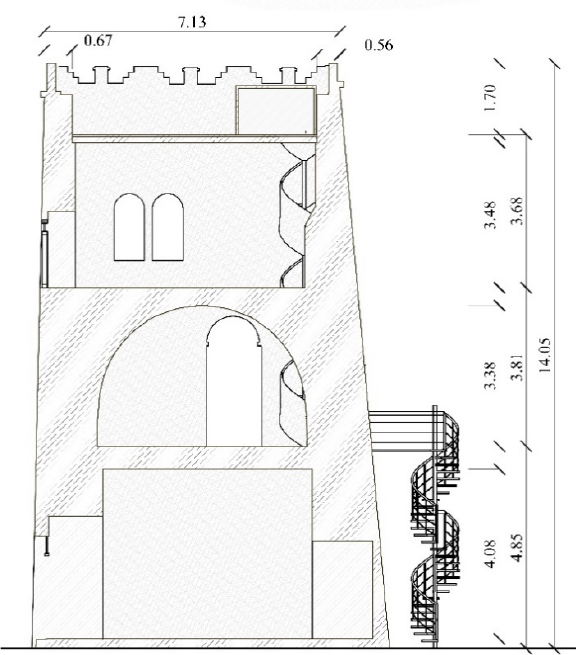
Figure 8. Cross section. Restauration proposal. Own